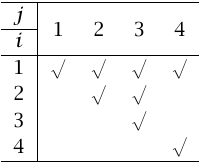
√ Table 1.2 . The mark “ ” indicates that for the corresponding case we